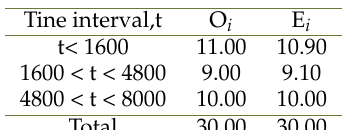
Table 1. Table of observed and pooled expected